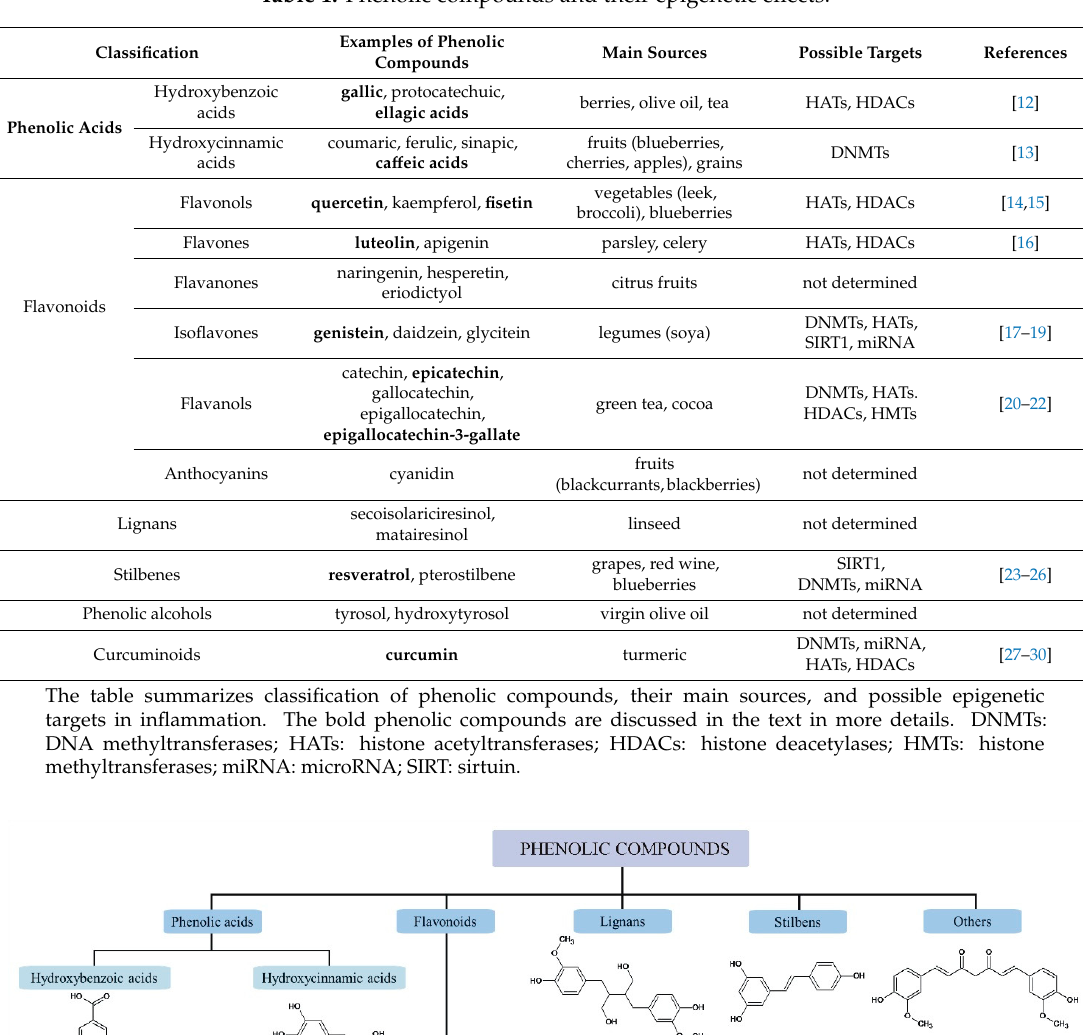
Table 1. Phenolic compounds and their epigenetic e ff ects.